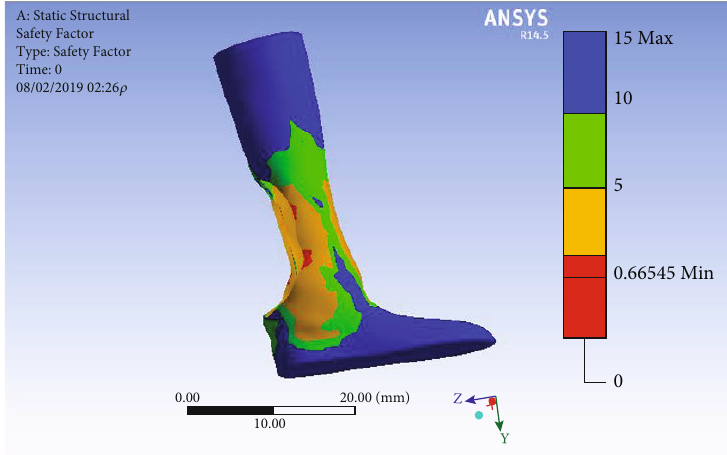
Figure 15: Group B fatigue factor of